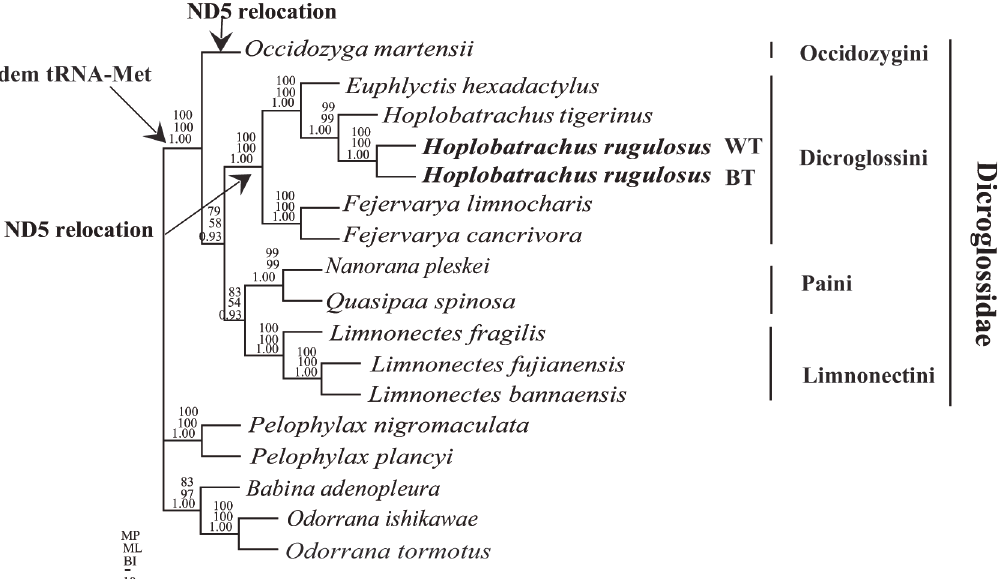
Fig 5. Phylogenetic relationships among Dicroglossidae and Ranidae. Phylogenetic analyses were carried out for the 17 frogs based on all 11 protein- coding genes from their respective mt genomes. The tree was rooted with five out-groups ( P . nigromaculata , P . plancyi , B . adenopleura , O . ishikawae , and O . tormotus ). Numbers above the nodes are the bootstrap values of MP and ML, and the posterior probabilities of